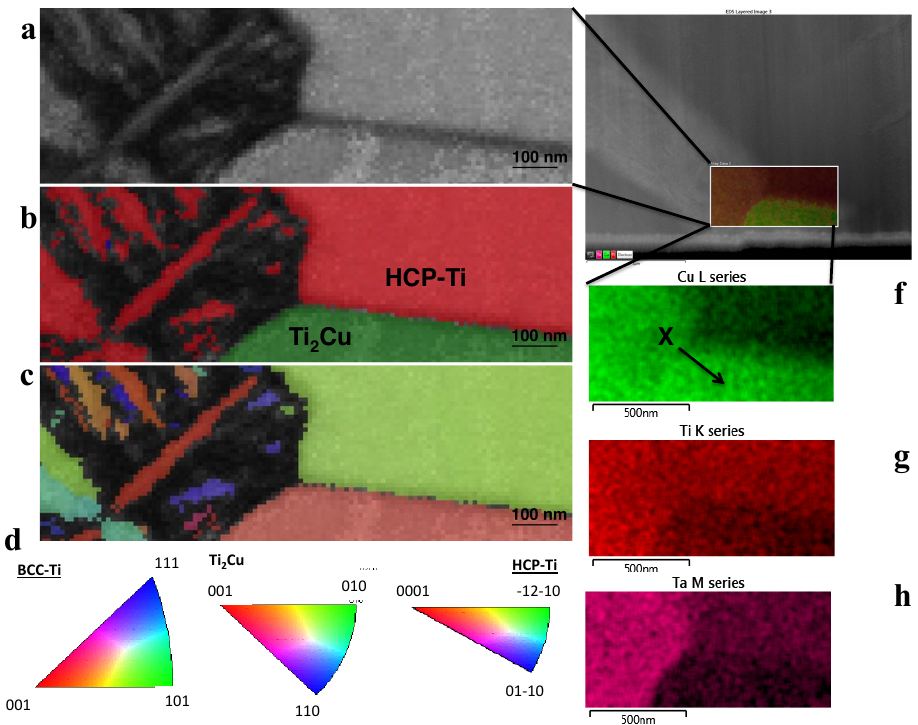
Figure 6. 5 wt.% Cu alloy studied using TKD and EDS. From the TKD study ( a ) displays band contrast, ( b ) a phase map and ( c ) IPF Z map of the same area with ( d ) associated pole figures. ( e ) An electron image of the area investigated with both techniques, ( f–h ) EDS maps of: ( f ) Cu L series (where X indicates Ti 2 Cu), ( g ) Ti K series and ( h ) Ta M series.